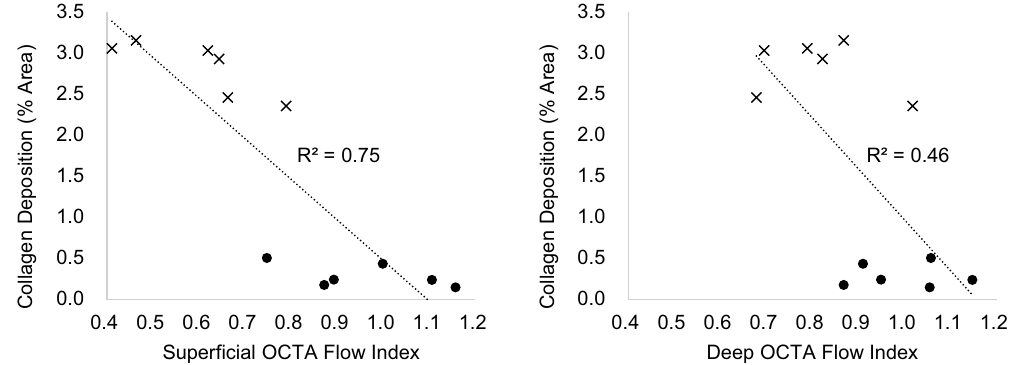
Figure 6. Correlation analysis between OCTA flow index and mean collagen area percentage in trichrome- stained slides. Collagen area was strongly correlated with superficial flow index and weakly correlated with deep flow index.